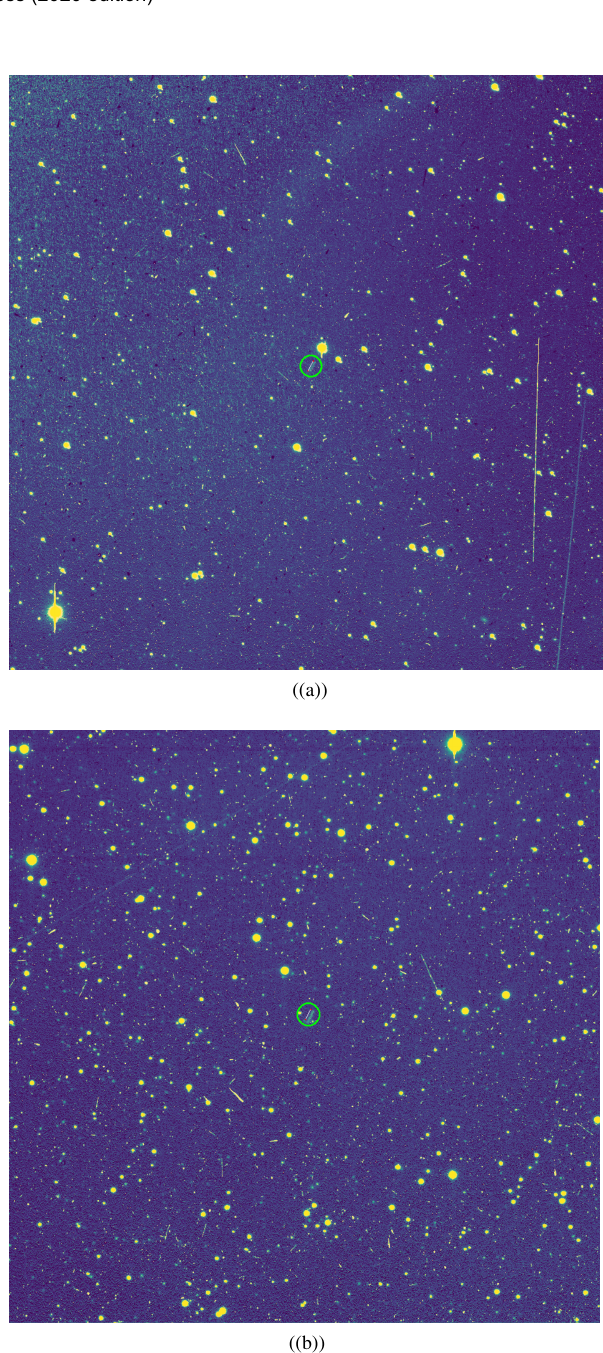
Figure 8. Detecting the short and dim paths of comet Borisov on (a) day 292 nd of 2019 with a path length of approximately 19 pixels and (b) day 306 th of 2019 with a path length of approximately 26